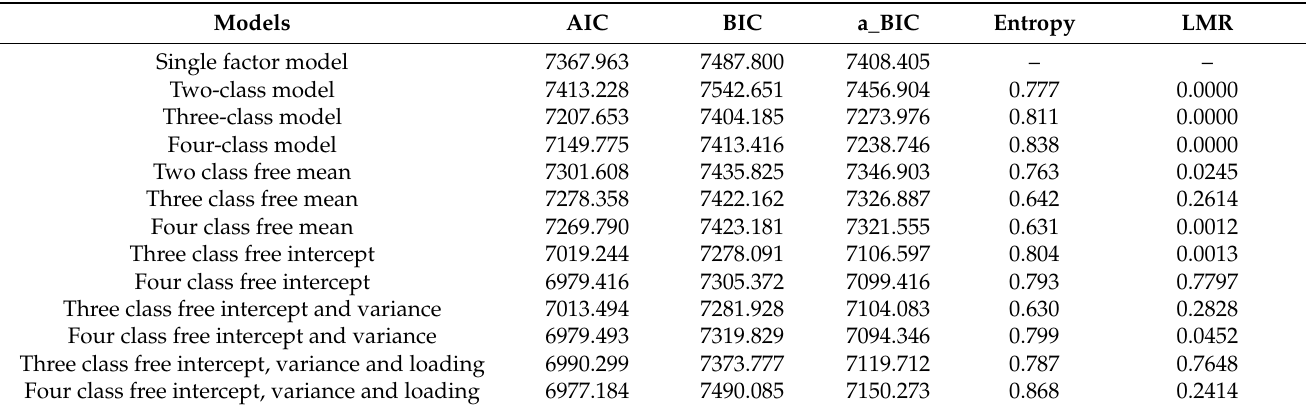
Table 3. Factor mixed sub models fitting